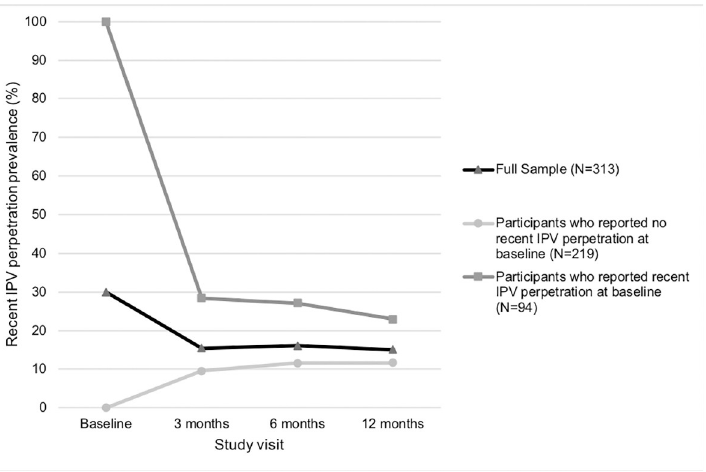
Fig 1. Prevalence of recent intimate partner violence perpetration among the full sample (N = 313), among those who reported no recent IPV perpetration at baseline (N = 219), and among those who reported recent IPV perpetration at baseline (N = 94). Abbreviations: IPV = Intimate partner